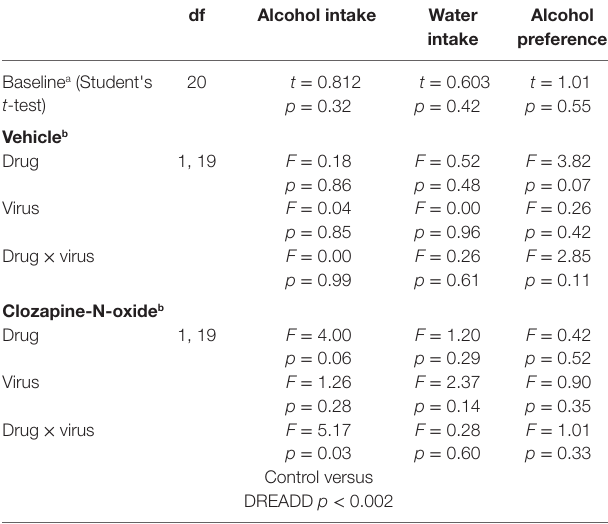
TaBle 1 | Analysis of alcohol-related behaviors in control-GFP versus hM 4 Di- mCherry designer receptors exclusively activated by designer drugs (DREADD)- expressing